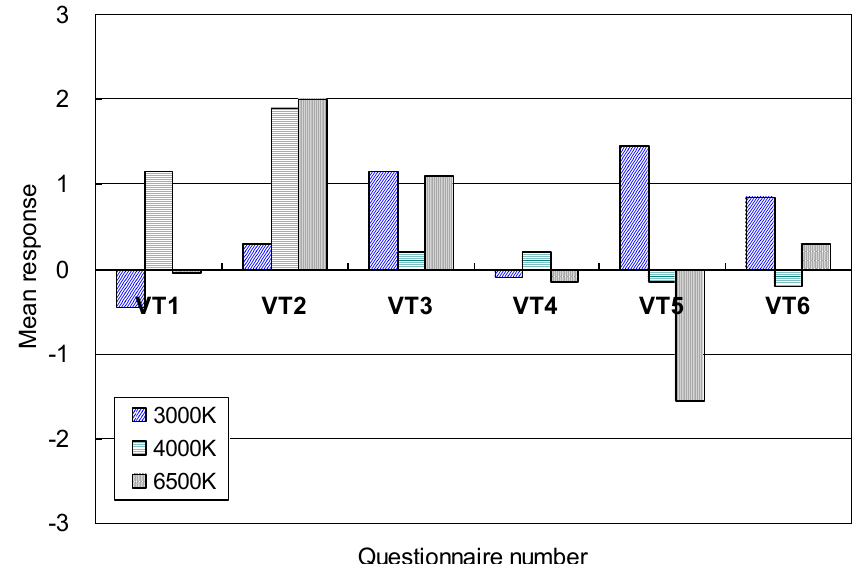
Figure 19. Perception of visual stimulation (750 lx condition, Paper